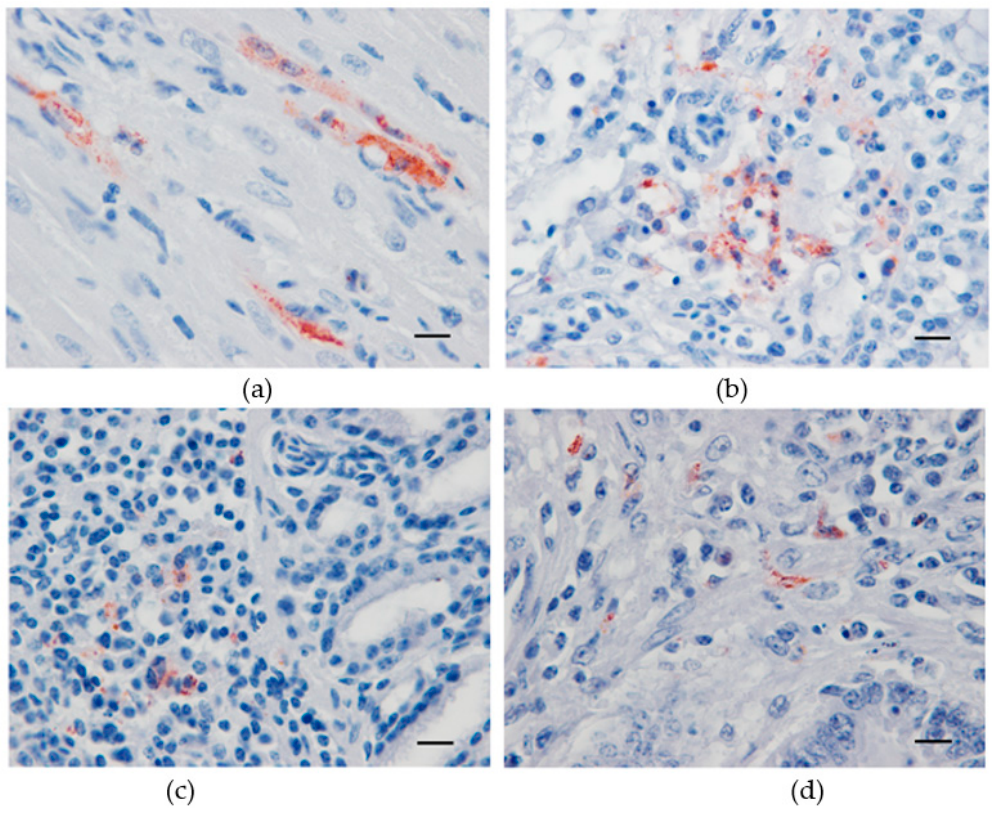
Figure 3. Immunohistochemical labeling of Usutu virus antigens in experimentally infected canaries using a mix of 4E9 and 4G2 anti-E protein monoclonal antibodies. Red-brown staining in antigen-positive cells from the heart ( a ), lung ( b ), lachrymal gland ( c ), and small intestine ( d ). Mayer hematoxylin counterstain, Scale bars: 10 µm.